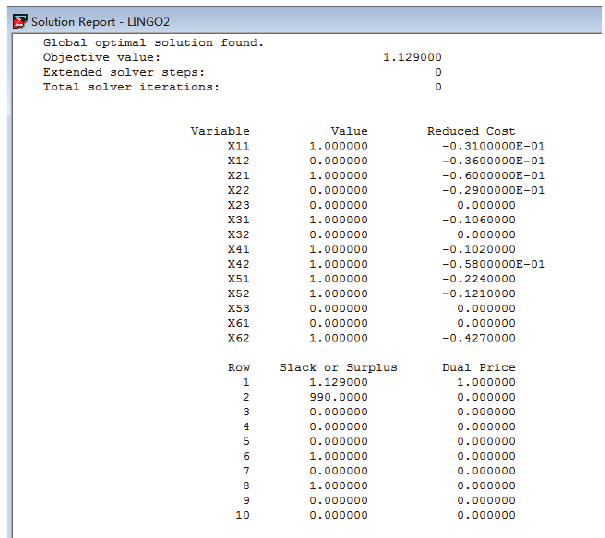
Figure 9: The service items selection diagram of Lingo.